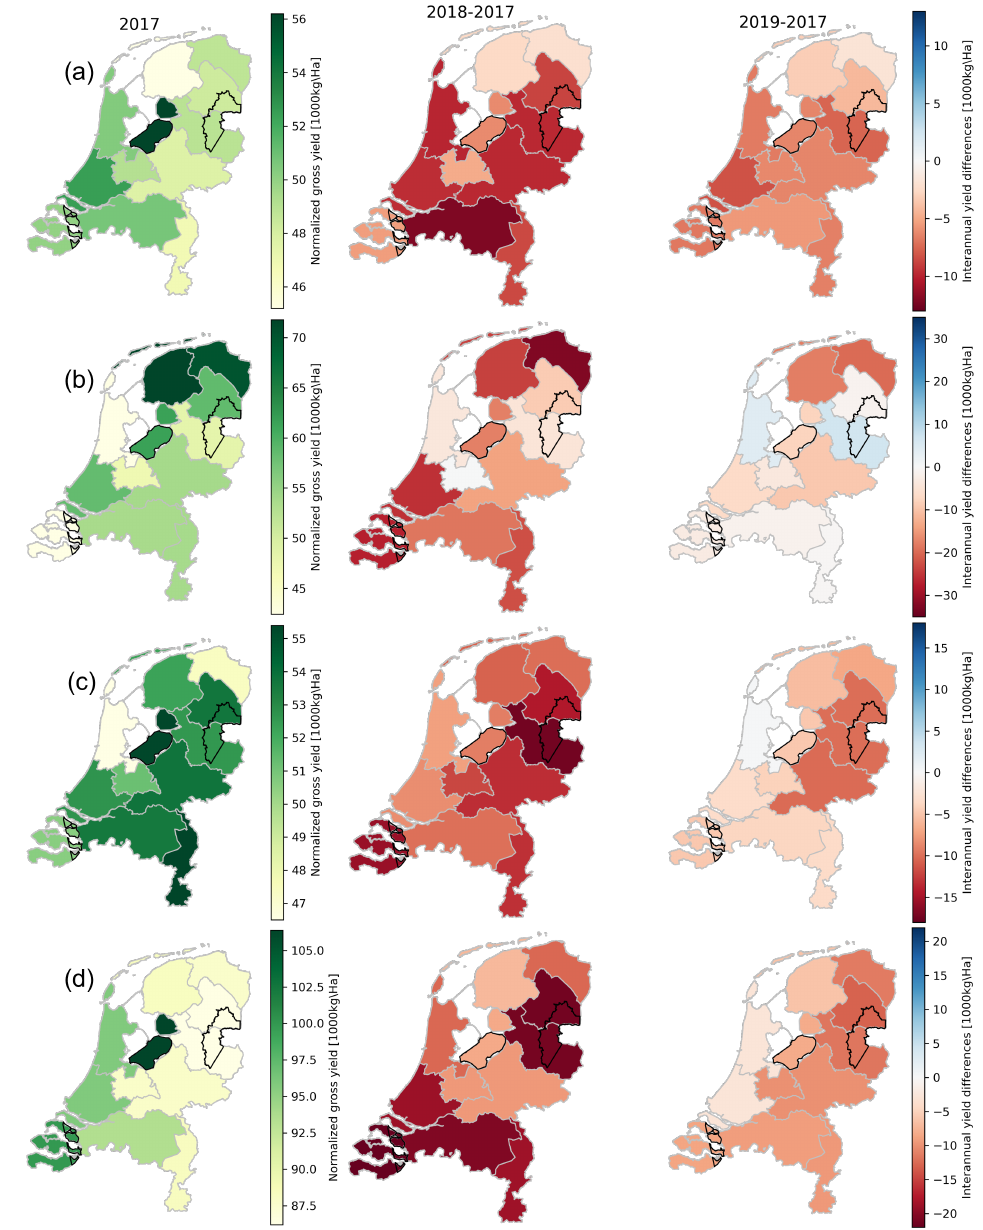
Figure 2. Normalized gross yield and inter-annual yield differences per province expressed in 1000 kg/ha for ( a ) maize, ( b ) onion, ( c ) potato, and ( d ) sugar beet. The left column shows the normalized gross yield for 2017 per province. The middle and right column shows the difference in yield between drought and “normal” years, i.e., 2018–2017 and 2019–2017, respectively. The black polygons indicate the three study